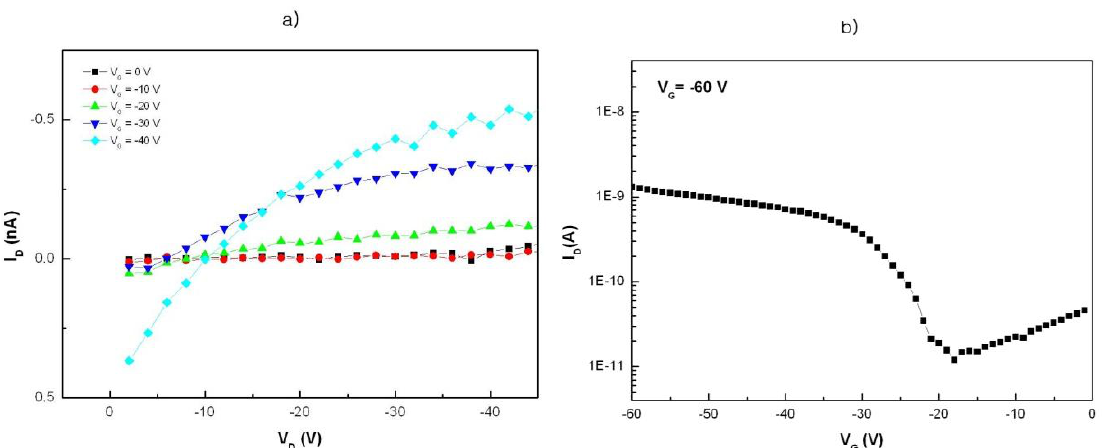
Figure 3. The typical plot of drain current I F8T2 TFTs. ( a ) Typical plot of the drain current I −40 V. and ( b ) The On/Off-curve of the organic semiconductor field effect transistor (organic